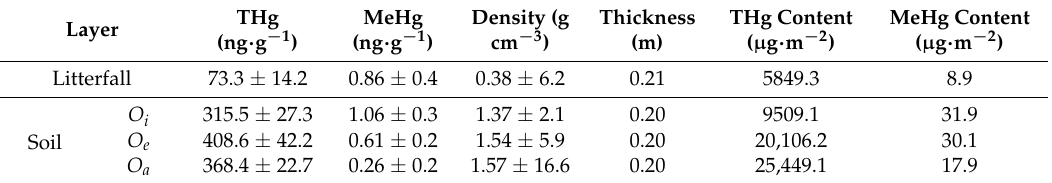
Table 1. THg and MeHg concentrations in different layers of the forest